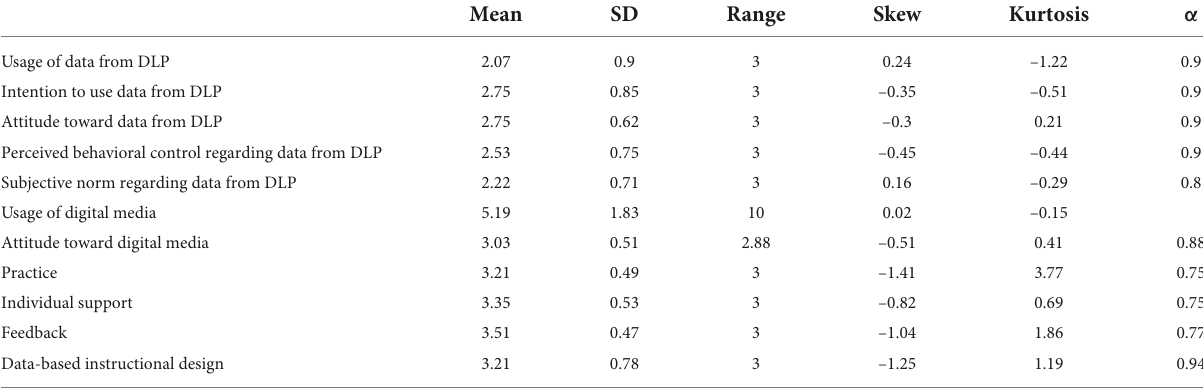
TABLE 2 Descriptive statistics and reliability